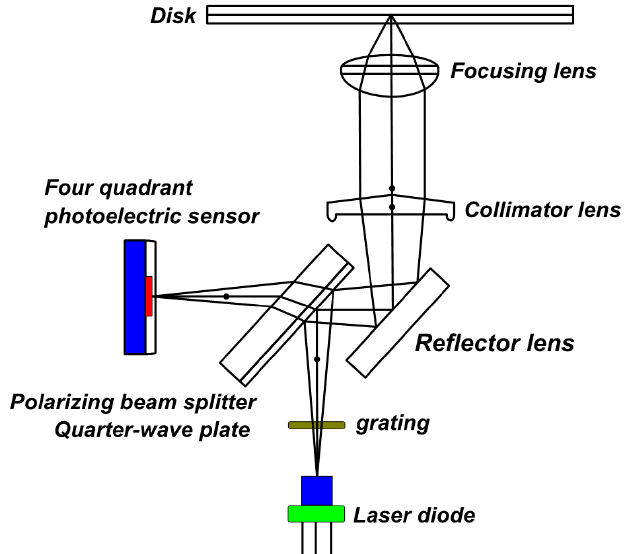
Figure 2. Optical path principle of the optical pickup